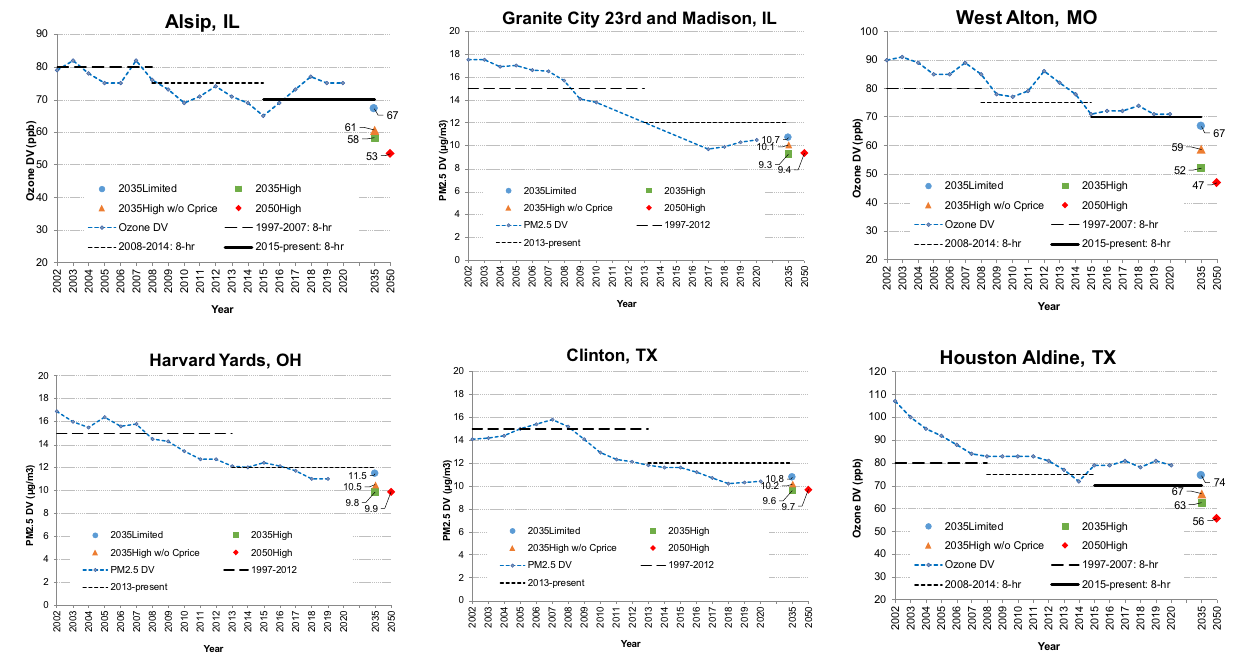
Fig. 3 | Historical (dotted line) ozone design values (DVs) at Houston Aldine (Texas), West Alton (Missouri), Alsip (Illinois) monitor (top row) and annual PM 2.5 DVs at Harvard Yards (Ohio), Clinton (Texas), and Granite City (Illinois) monitor (bottom row). Also shown are the relevant U.S. National Ambient Air